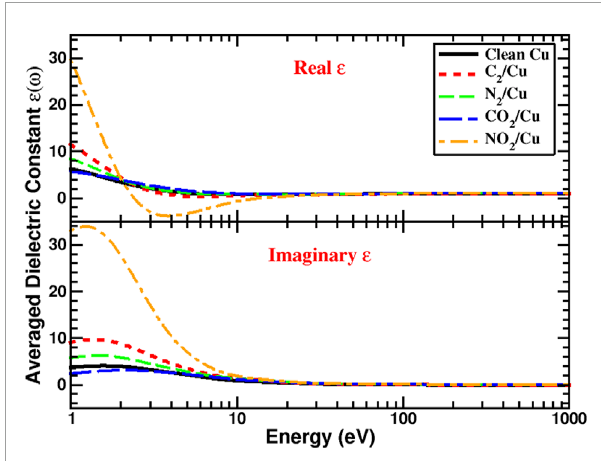
FIGURE 2 Calculated real and imaginary part of the averaged dielectric constants for the clean Cu (110), C 2 /Cu (110), N 2 /Cu (110), CO 2 /Cu (110), and NO 2 /Cu (110) surfaces.